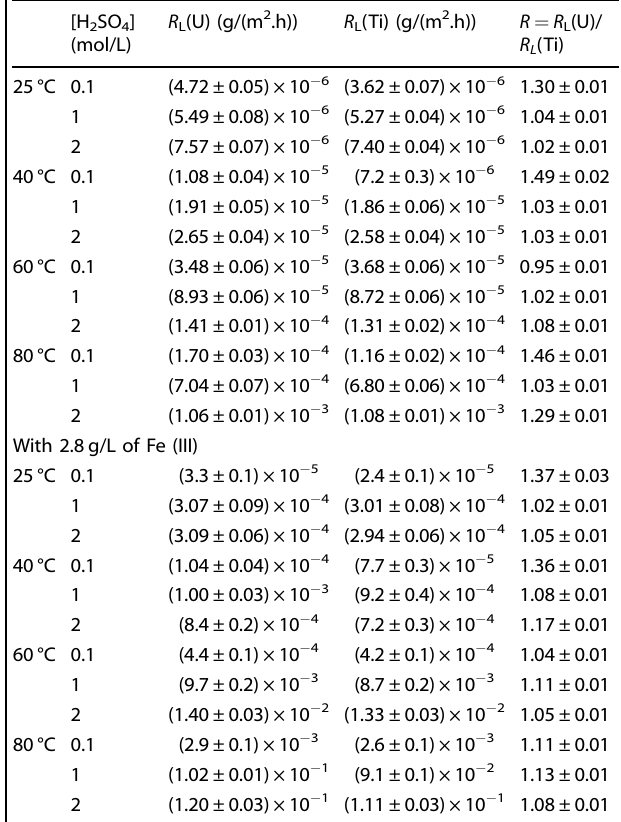
Table 1. Normalized dissolution rates R L (U) and R L (Ti) obtained during the dissolution of synthetic brannerite samples in various conditions (with and without Fe(III)). Associated congruence ratios, R = R L (U)/ R L (Ti) .